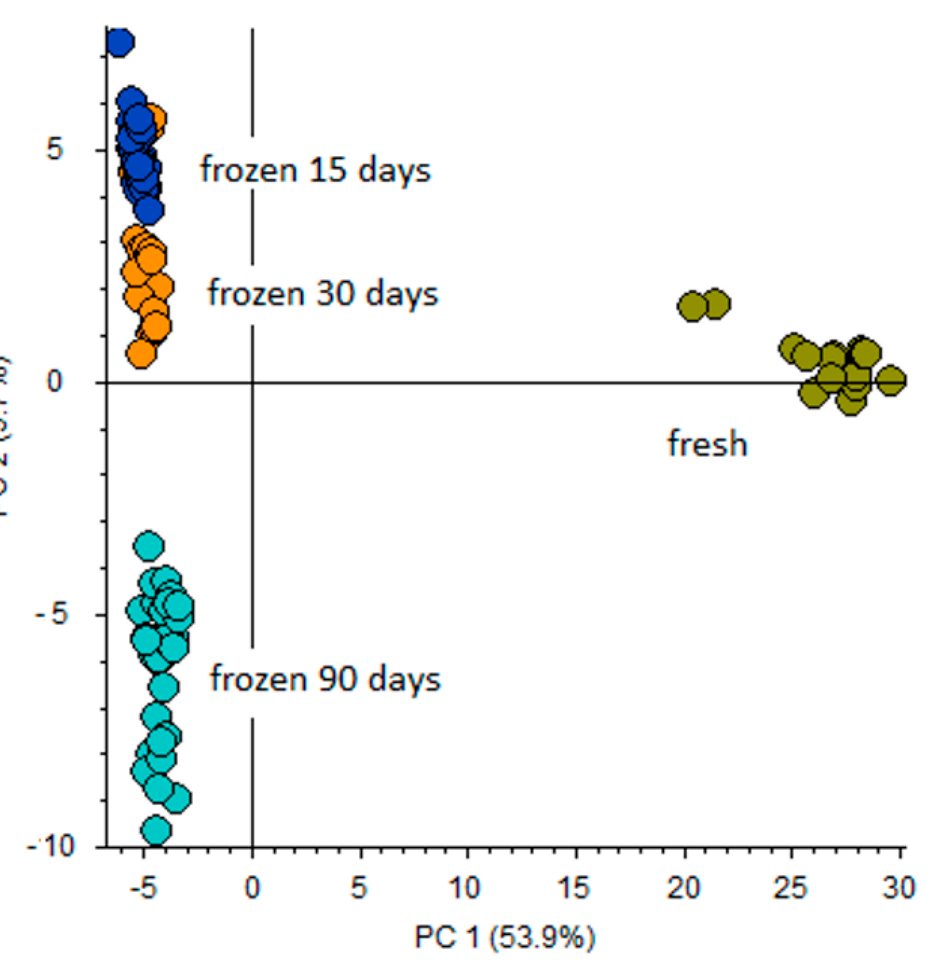
Figure 3. Principal component analysis (PCA) projection on the distribution of fresh and pulled frozen / thawed bullet tuna samples as regards PC-1 with PC-2 when high resolution mass spectrometry (HRMS) spectral characterization of normalized peak area was used.